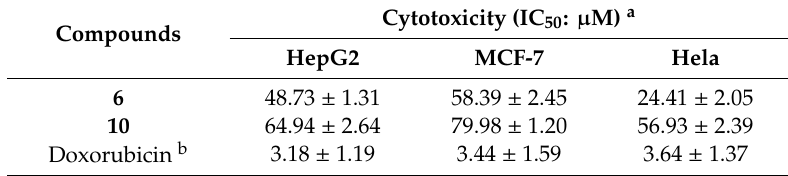
Table 3. Cytotoxicity of compounds 6 and 10 against three human cancer cell